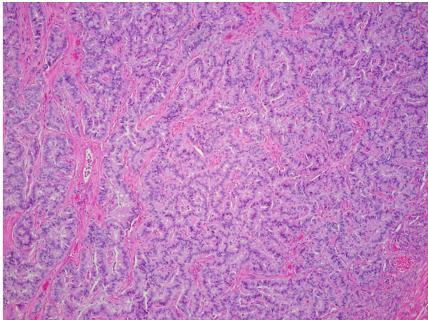
Figure 3: Neuroendocrine component (carcinoid) with trabecular tumor cell arrangement.